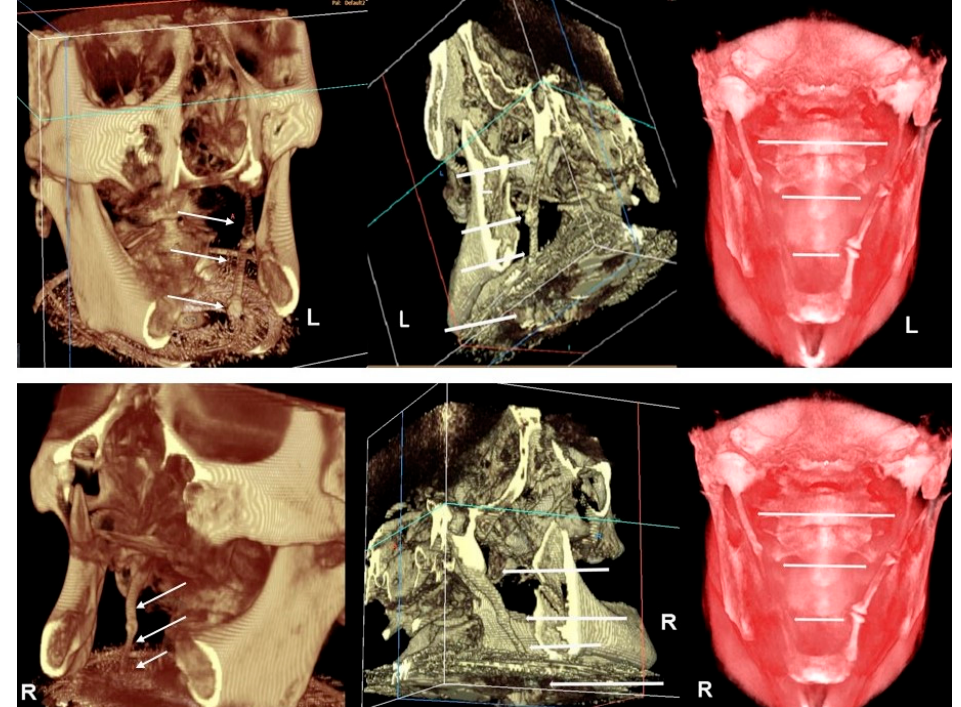
Figure 5. Top image –CBCT three-dimensional reconstruction shows an impressive calcification of the SHC in di ff erent image modes (left–default 2 mode, center–default mode, right-skin / red mode throughout antero-posterior slice sectioning). On the left side, the CBCT radiographic appearance of a “collar-like” and elongated SHC shows a multi-interrupted and segmented calcified SHC, fully stretched to the lesser cornu of the hyoid bone (see arrows). Bottom image –in a di ff erent image mode, on the right side, CBCT three-dimensional reconstruction shows the segmented calcified SHC which barely reaches the lesser cornu of the hyoid bone (left–default 2 mode, center–default mode, right–skin / red mode throughout antero-posterior slice sectioning) (see arrows).